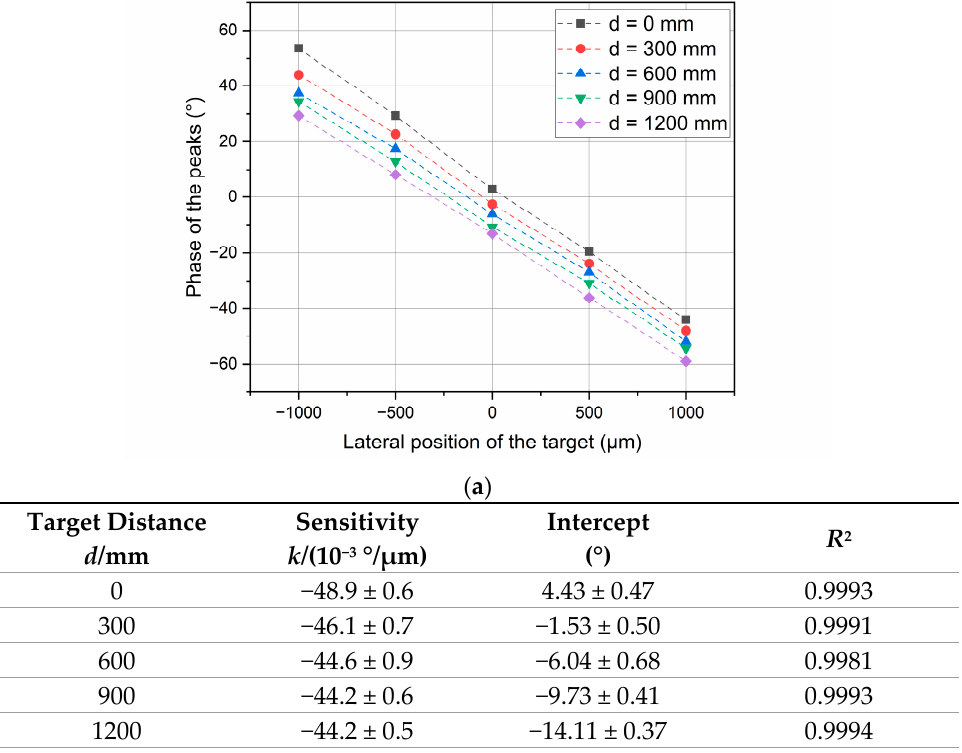
Figure 15. Calibration of P3: calibration curves at different distances to the target ( a ) and results of the linear best-fitting (values and standard deviations). ( b ) The time separation of the peaks is expressed as a phase (unlike in Figure 10a (P2), which is expressed as a time interval).